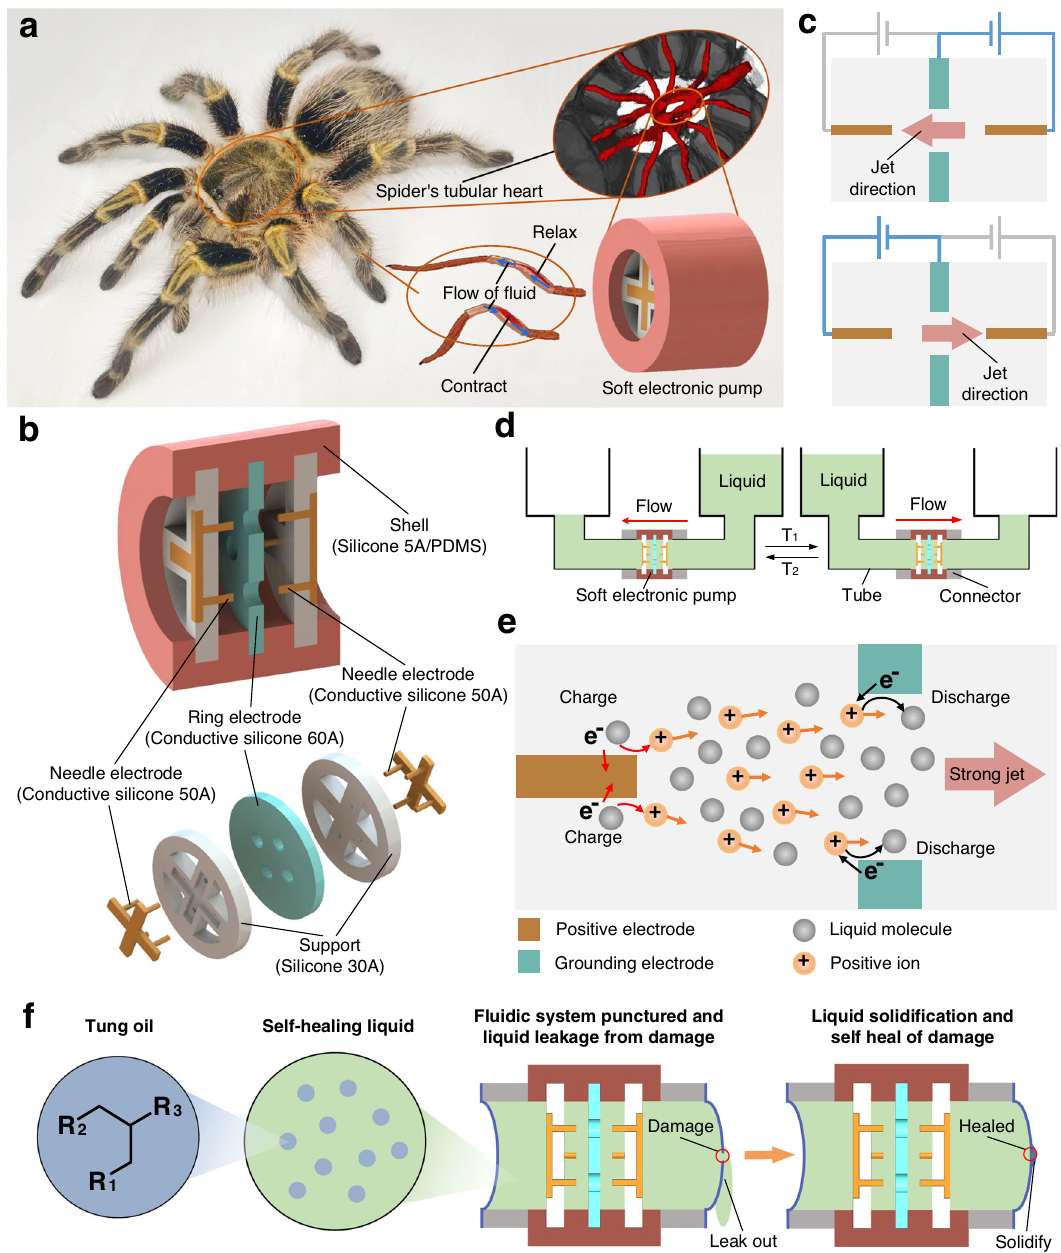
Fig. 1 Bio-inspiration, architectures, operational principle, and self-healing liquid of soft electronic pumps. a The built-in bio-hydraulic actuation system of the spider. Spider utilizes its tubular heart to pump the hemolymph to its foot, thereby driving the foot joint to extend. b Architectures of soft electronic pumps. All the components of pumps, including needle electrodes, ring electrodes, supports, and shells, are made of soft materials, which make the pump fully soft and stretchable. Needle-hole electrode pair in pumps forming the minimum electrode pair modular unit is used to move liquid. c Schematic of pump ’ s reversibly bidirectional pumping capability. The pumping direction can be reversibly changed by selectively applying with voltages. d Schematic of pumping liquid between two cylindrical liquid reservoirs by the soft electronic pump. The pumping time T 1 and T 2 can be controlled by adjusting the applied voltages. e Operational principle of soft electronic pumps. Free ions are generated by the positively charged process when applied to a strong electric fi eld, and then these ions subjected to the action of Coulombic forces will move along the electric fi eld lines from the positive electrode to grounding electrodes, directly dragging neutral liquid molecules fl ow to form a strong jet. The negatively discharged process re-forms these ions into neutral liquid molecules when they reach the grounding electrodes. f Schematic of self-healing liquid pumped by soft electronic pump to heal the damages. The self-healing liquid is fabricated by dissolving evenly tung oil into dibutyl sebacate, which can form a solid fi lm when exposed to will stop as the electric fi eld is removed. Theoretical model and numerical simulation of the operational principle can be seen in “ Methods ” section and Supplementary Fig. 4, where the dis- tributions of electric potential, charge density, and velocity in the soft electronic pump are presented.